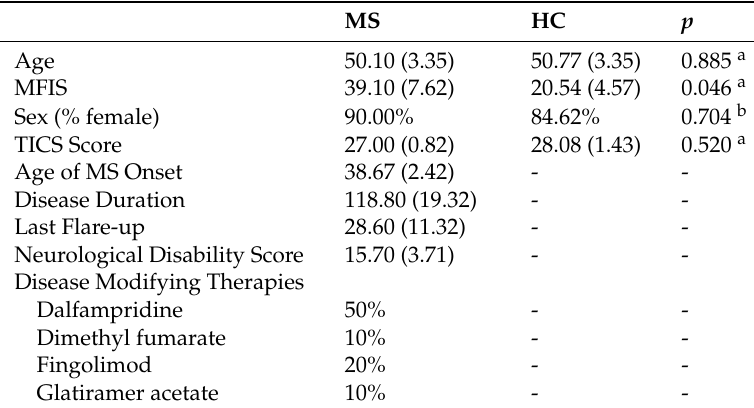
Table 1. Group Characteristics.